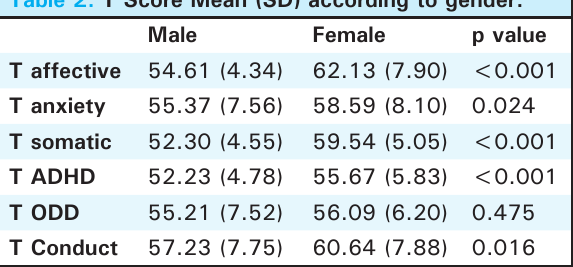
Table 2. T Score Mean (SD) according to gender.